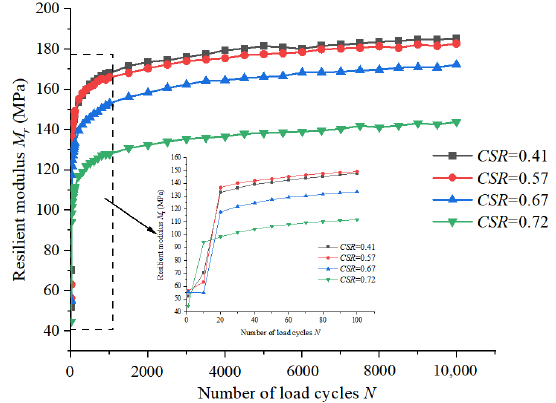
Figure 13. Relationship between resilient modulus and number of loading cycles of samples with different CSR .